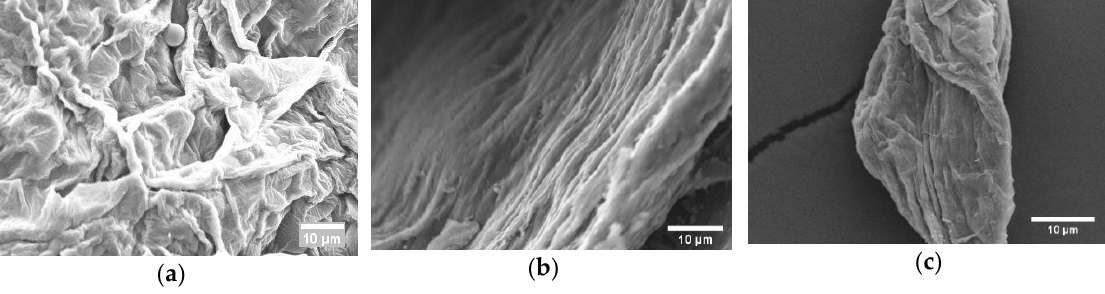
Figure 6. SEM image of ( a ) raw CP, ( b ) CNF procedure I, and ( c ) CNF procedure II.